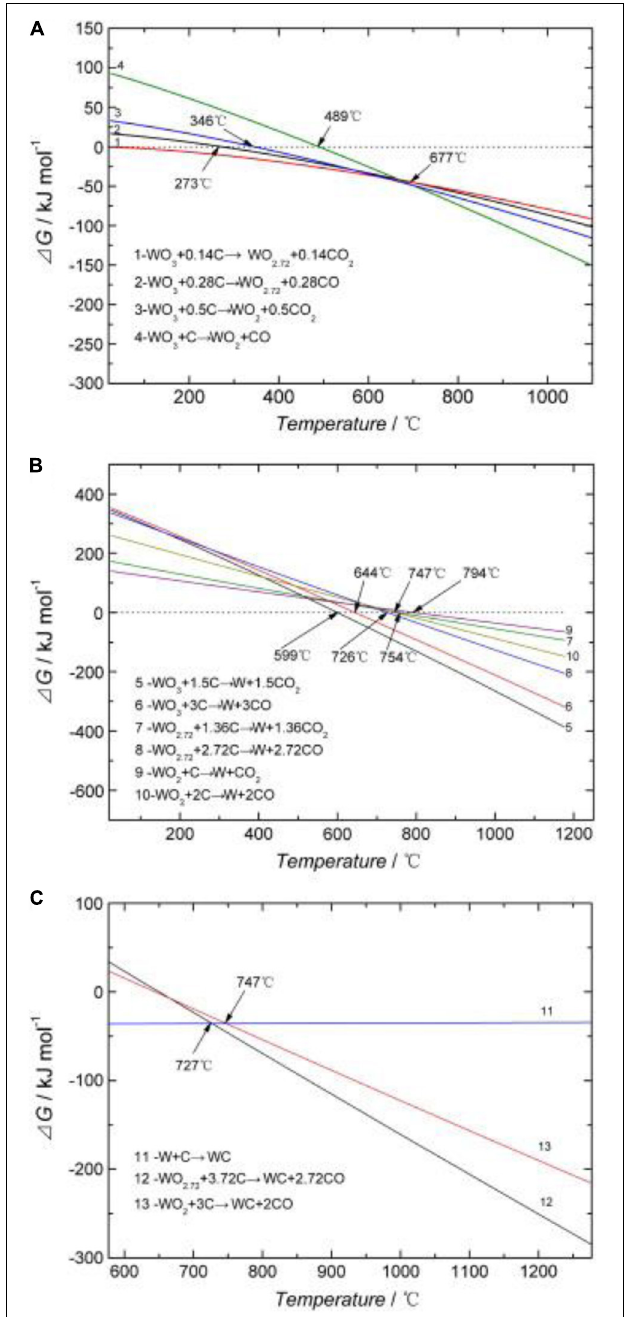
FIGURE 5 | Changes of (cid:49) G with the temperature of different tungsten oxides when reacting with graphite: (A) Magneli-phase WO 3 formation; (B) W formation; (C) WC formation (Ma and Zhu, 2010) [Figure 4 of Ma and Zhu (2010), Copyright Elsevier Ltd.].